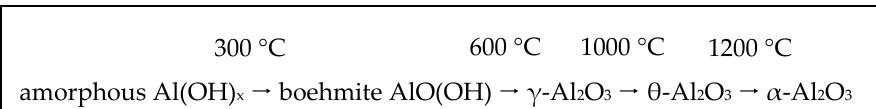
Figure 3. Phase transformations following the boehmite path, adapted from [68].